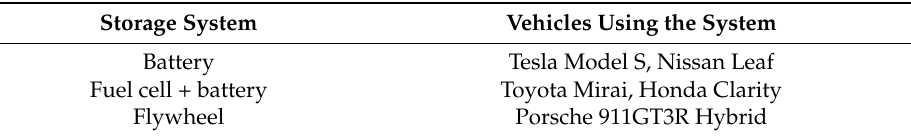
Table 14. Vehicles using different storage